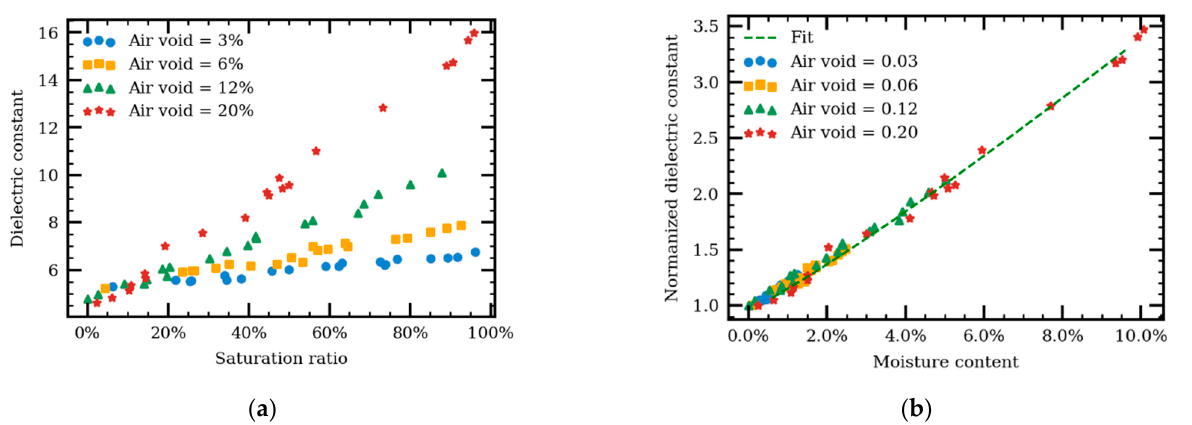
Figure 12. Effects of the saturation ratio and air voids on the dielectric constant ( a ) as well as the effects of the moisture content and air voids on the normalized dielectric constant ( b ).